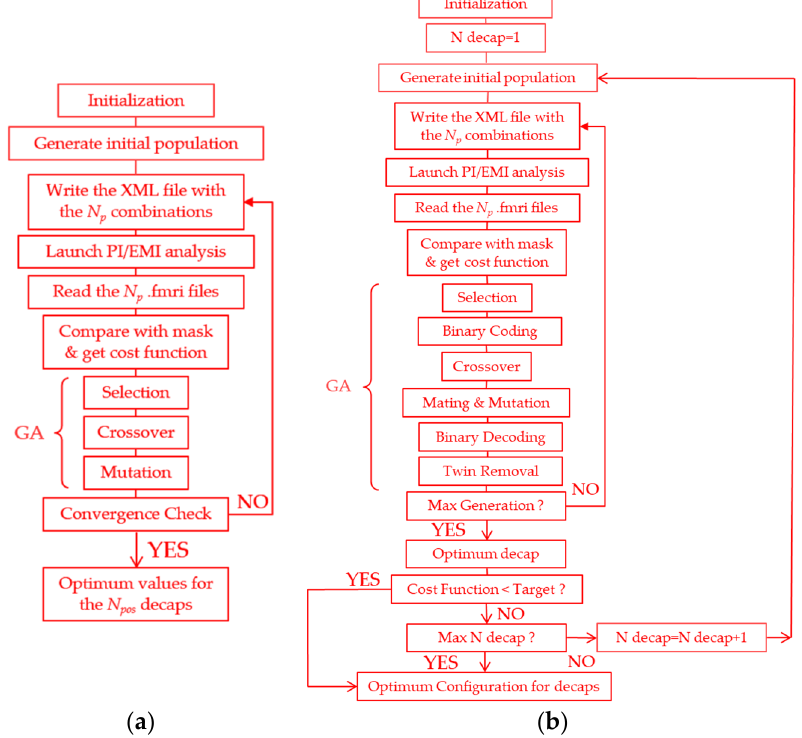
Figure 1. High-level genetic algorithm (GA) optimization flow: ( a ) Algorithm from Reference [14] and ( b ) the proposed improved iterative algorithm.